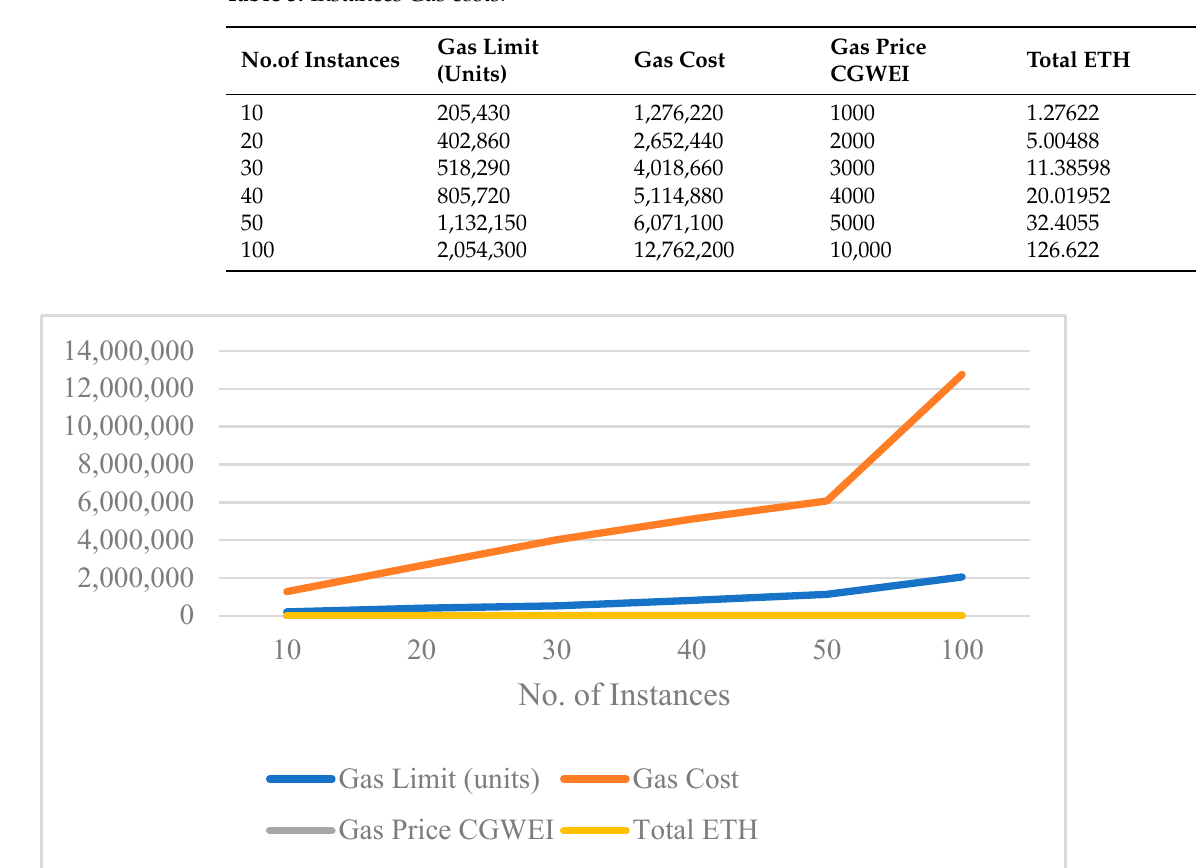
13 of 17 Figure 5. Comparison between before after optimizing the BGF-CNN model. In comparison to the GFB-CNN technique [28], IoT-CMS [1] based system, and IoMT- PLM system [2], the suggested BGF-based system overhead is decreased by 50%, 60%, and more than 80%, respectively, as shown in Figure 5. Table 5 demonstrates that the gas cost generates certificates with a 15-second block generation time without accounting for block header overhead. Figure 6 visualizes the results of Table 5.